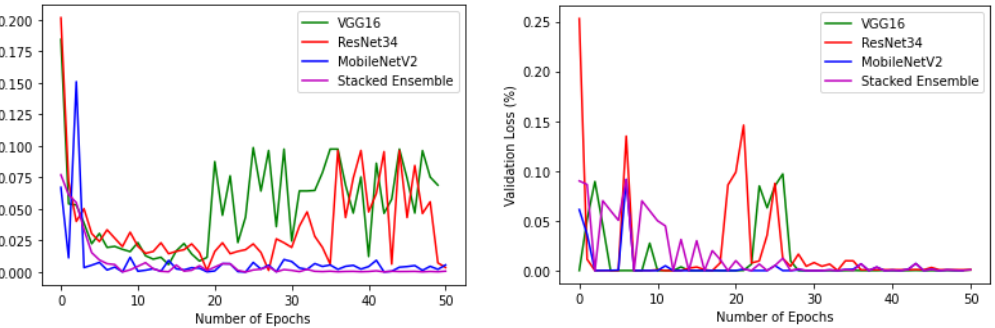
Figure 14. Training and validation loss of base-learners with VGG16, Resnet34, MobilenetV2, and Ensemble models, respectively, for the reduced dataset.